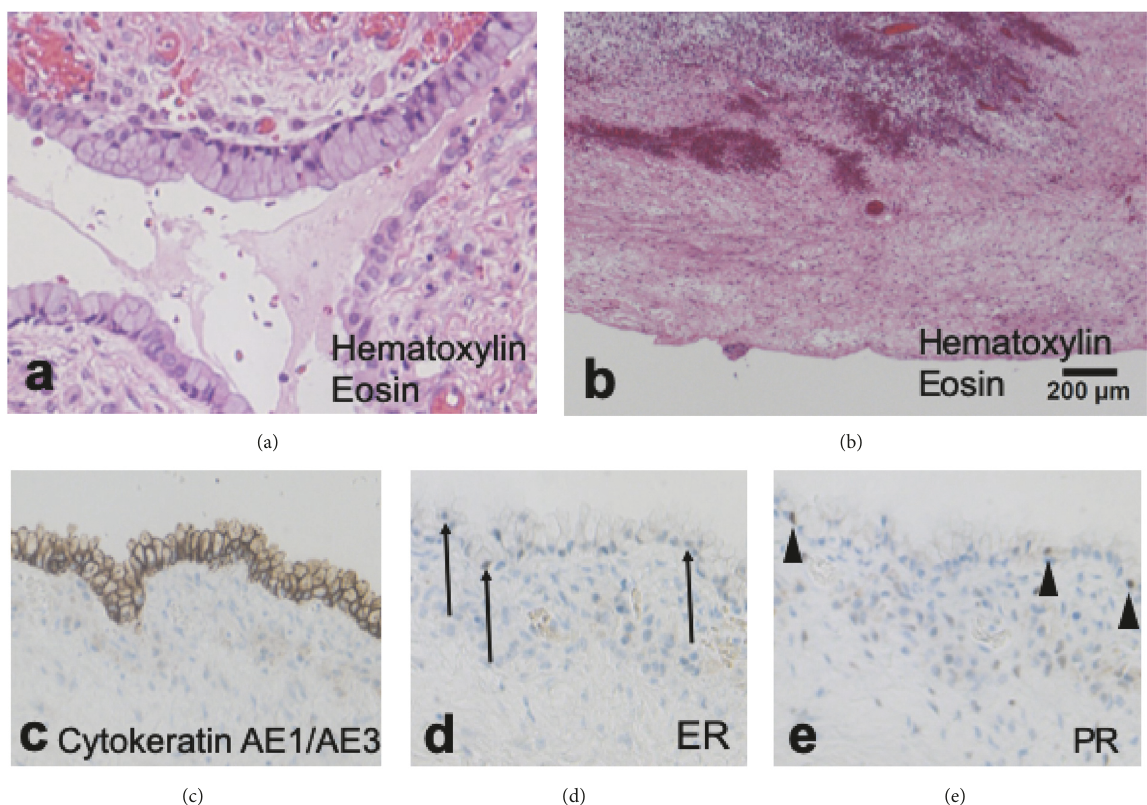
Figure 3: Histological findings of the right ovarian tumor (a-d). (a) The epithelium of the right ovarian tumor without dysplasia contains mucin. It is consistent with mucinous cystadenoma (Hematoxylin and Eosin stain, x20). (b) The large cyst wall containing serous fluid shows partial defects of epithelium. This is due to adhesion of the abdominal cavity and cyst. (c-e) The large cyst wall is strongly positive, partly weakly positive (arrows), and partly positive (arrowheads) for cytokeratin AE1/AE3, estrogen receptors (ER), and progesterone receptors (PR), respectively (x20).